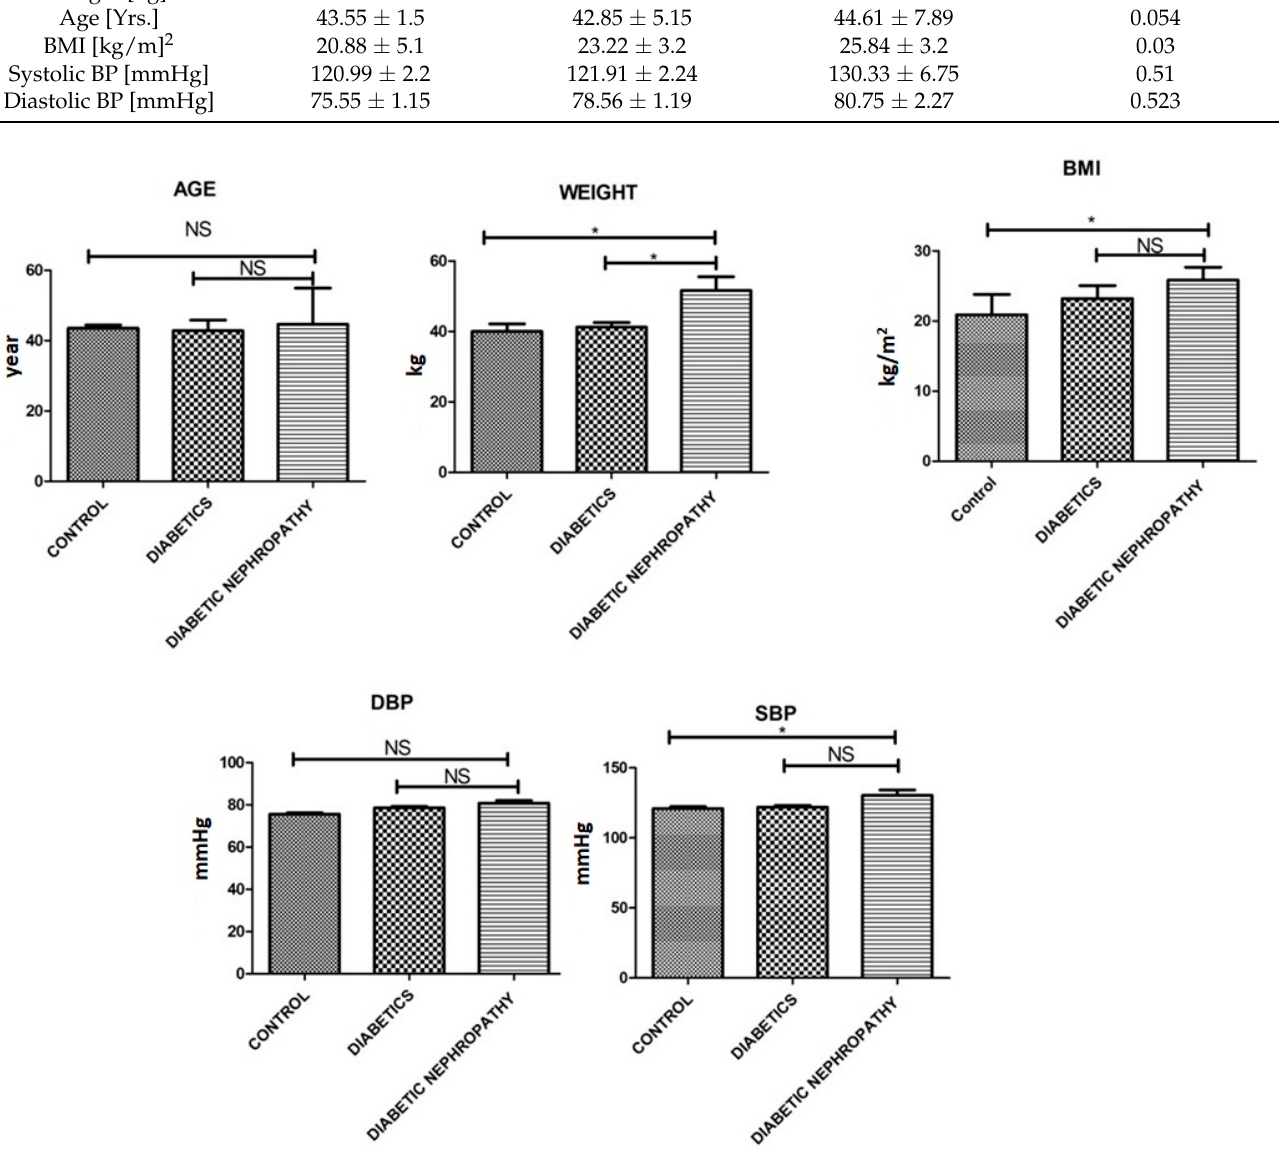
Figure 2. Age, weight, BMI, systolic and diastolic blood pressure of all the individuals. There is a significant difference between control and diseased group, an elevated level of BMI and weight can be observed between control vs. diseased group. Where p ≤ 0.05, * (less significance) represents the significant difference between groups.